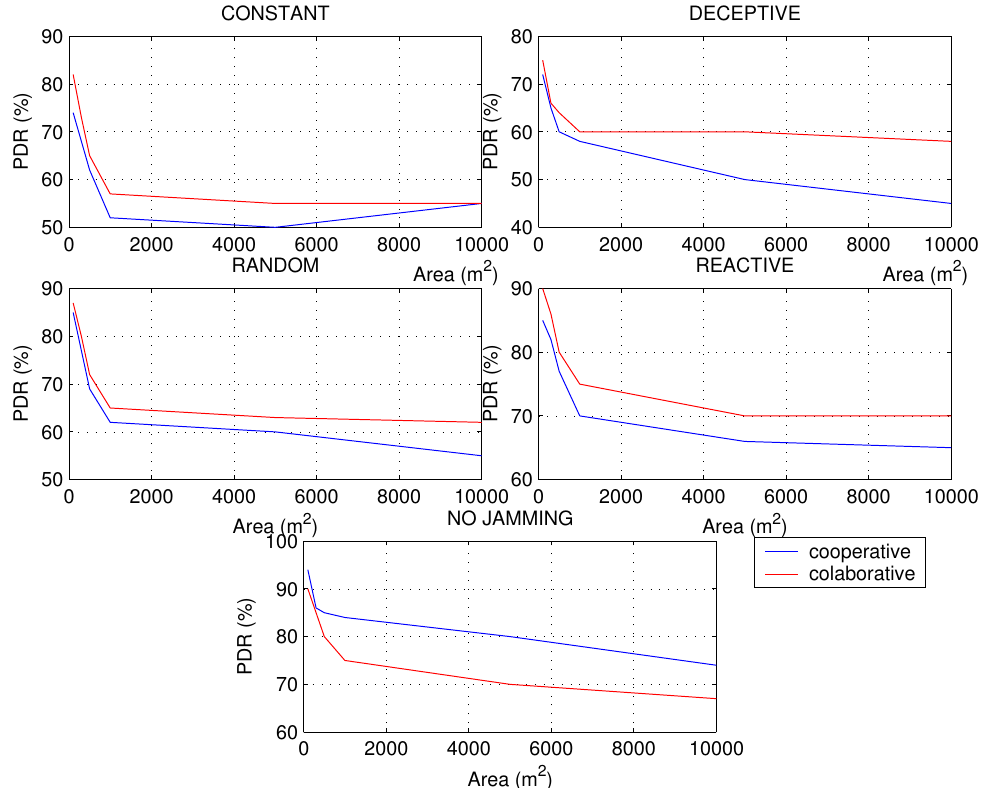
Figure 11. PDR for types of jamming in a WSN of 200 nodes with different areas under collaborative and cooperative